Question: What visual encoding does this figure use to show its data?
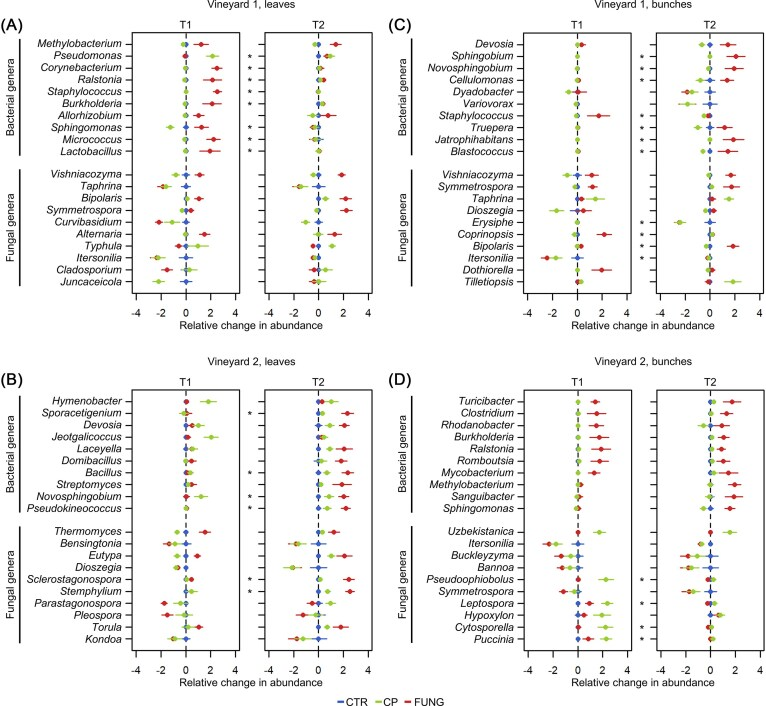
Answer: bar